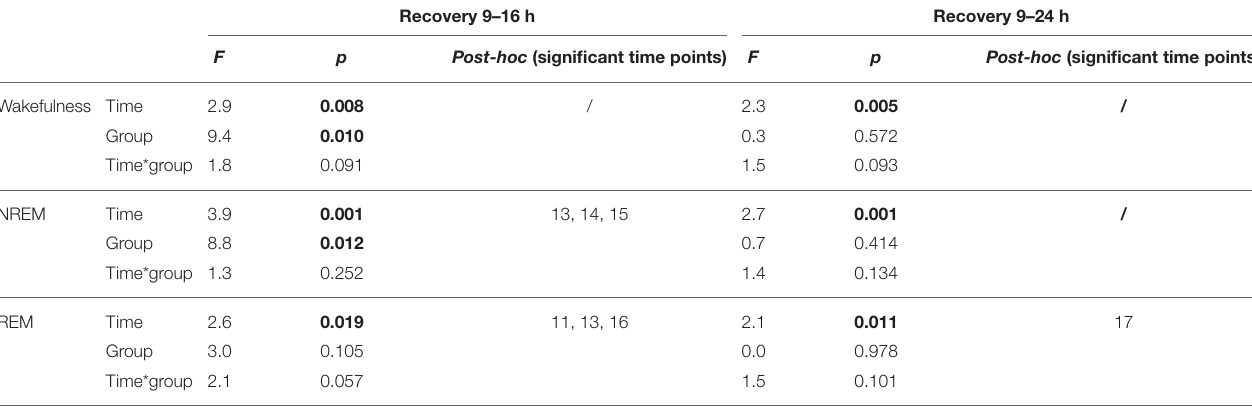
TABLE 1 | Statistical analysis of differences between baseline and recovery sleep in wakefulness, NREM and REM sleep in controls and in ammonium-treated animals over two time intervals: 9–16 and 9–24